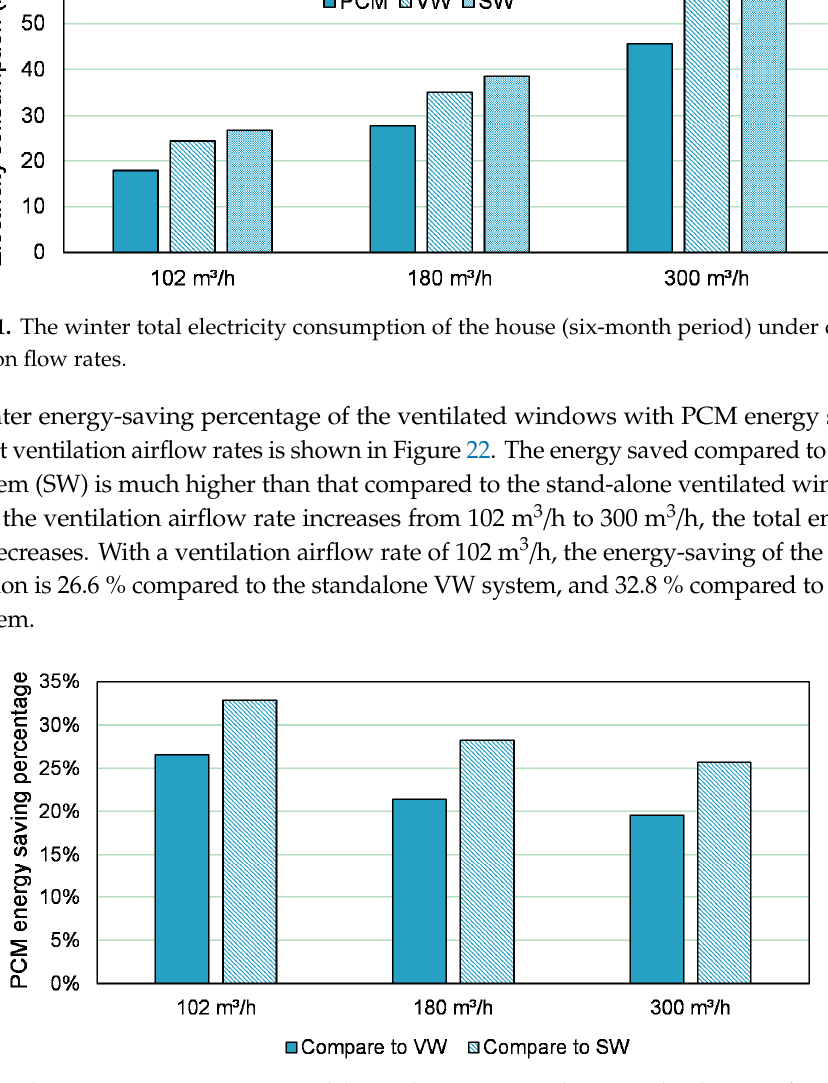
Figure 22. The PCM energy-saving potential during the winter period compared to the two reference cases.